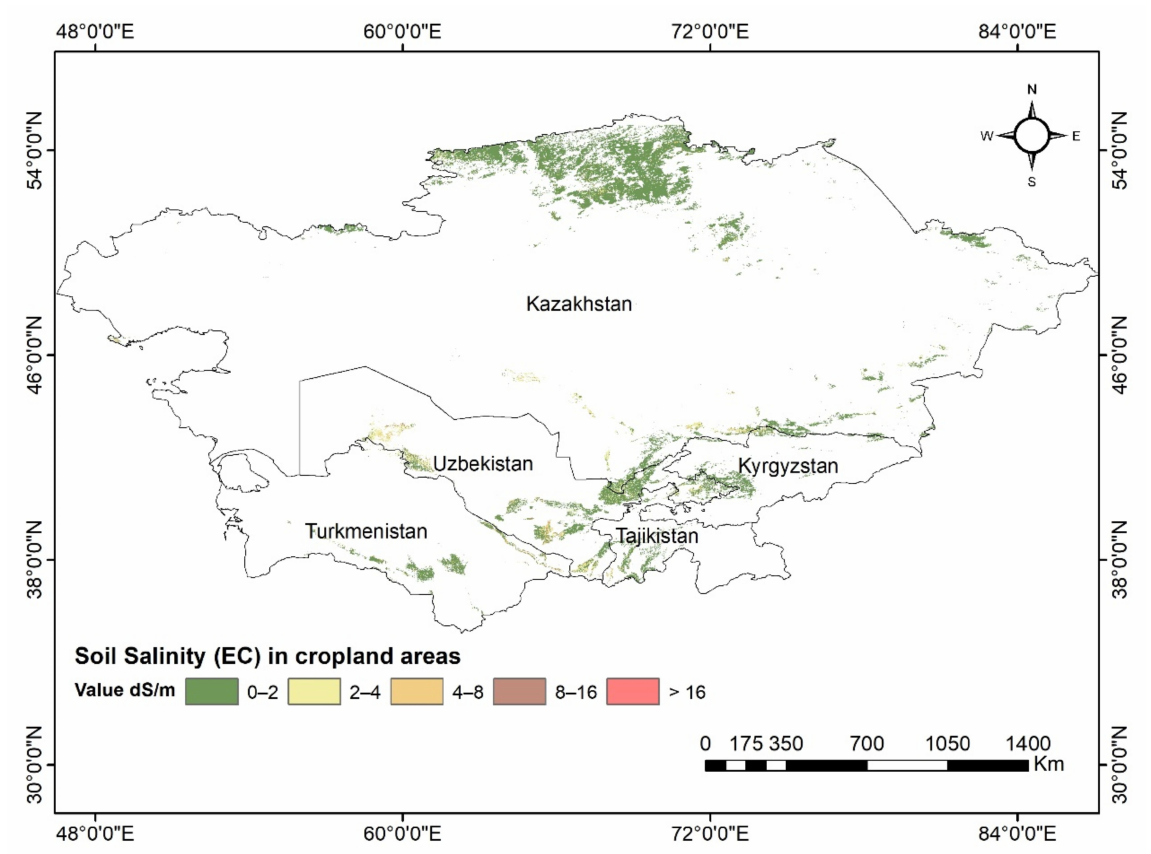
Figure 4. Soil salinity distributions and EC classes for 2018 cropland areas in Central